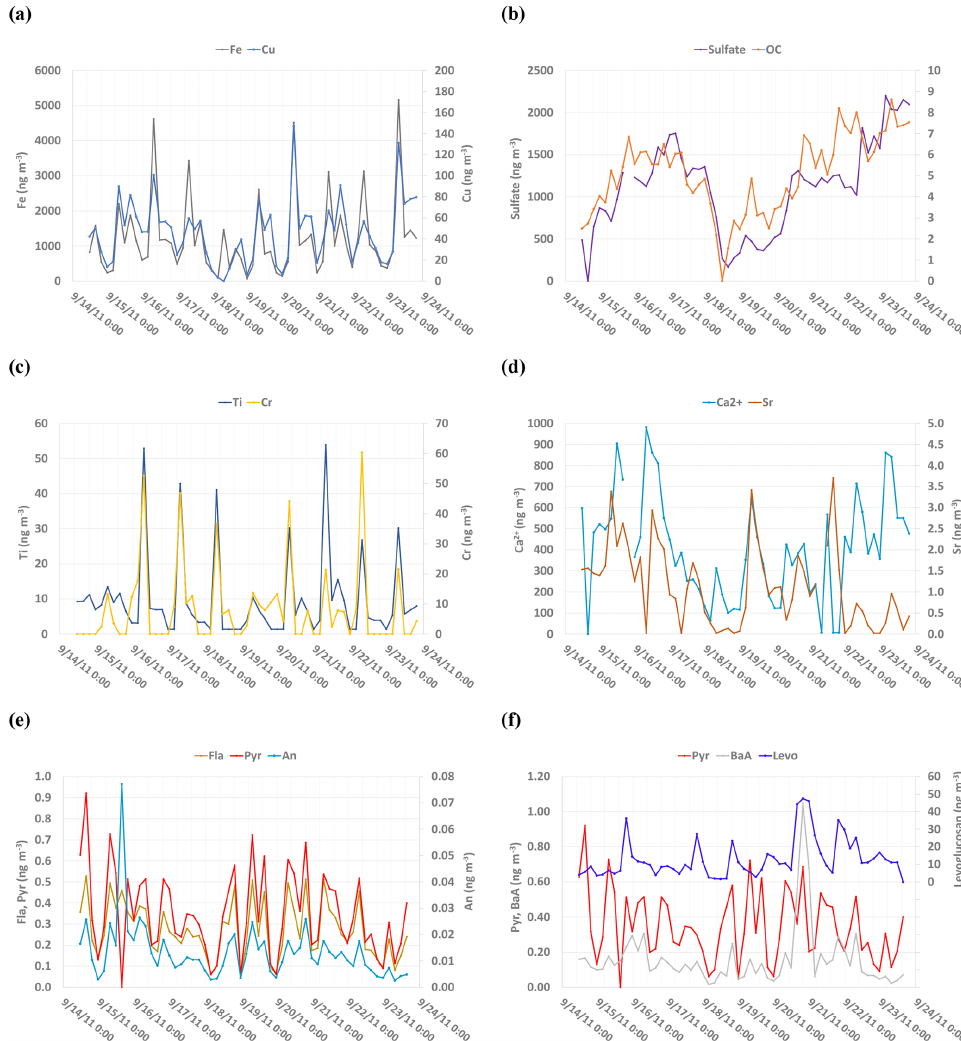
Figure 3. The 4h concentrations measured at the traffic site: (a) iron and copper; (b) sulfate and organic carbon; (c) chromium and titanium; (d) calcium and strontium; (e) fluoranthene, pyrene and anthracene; and (f) pyrene, benzo(a)anthracene and